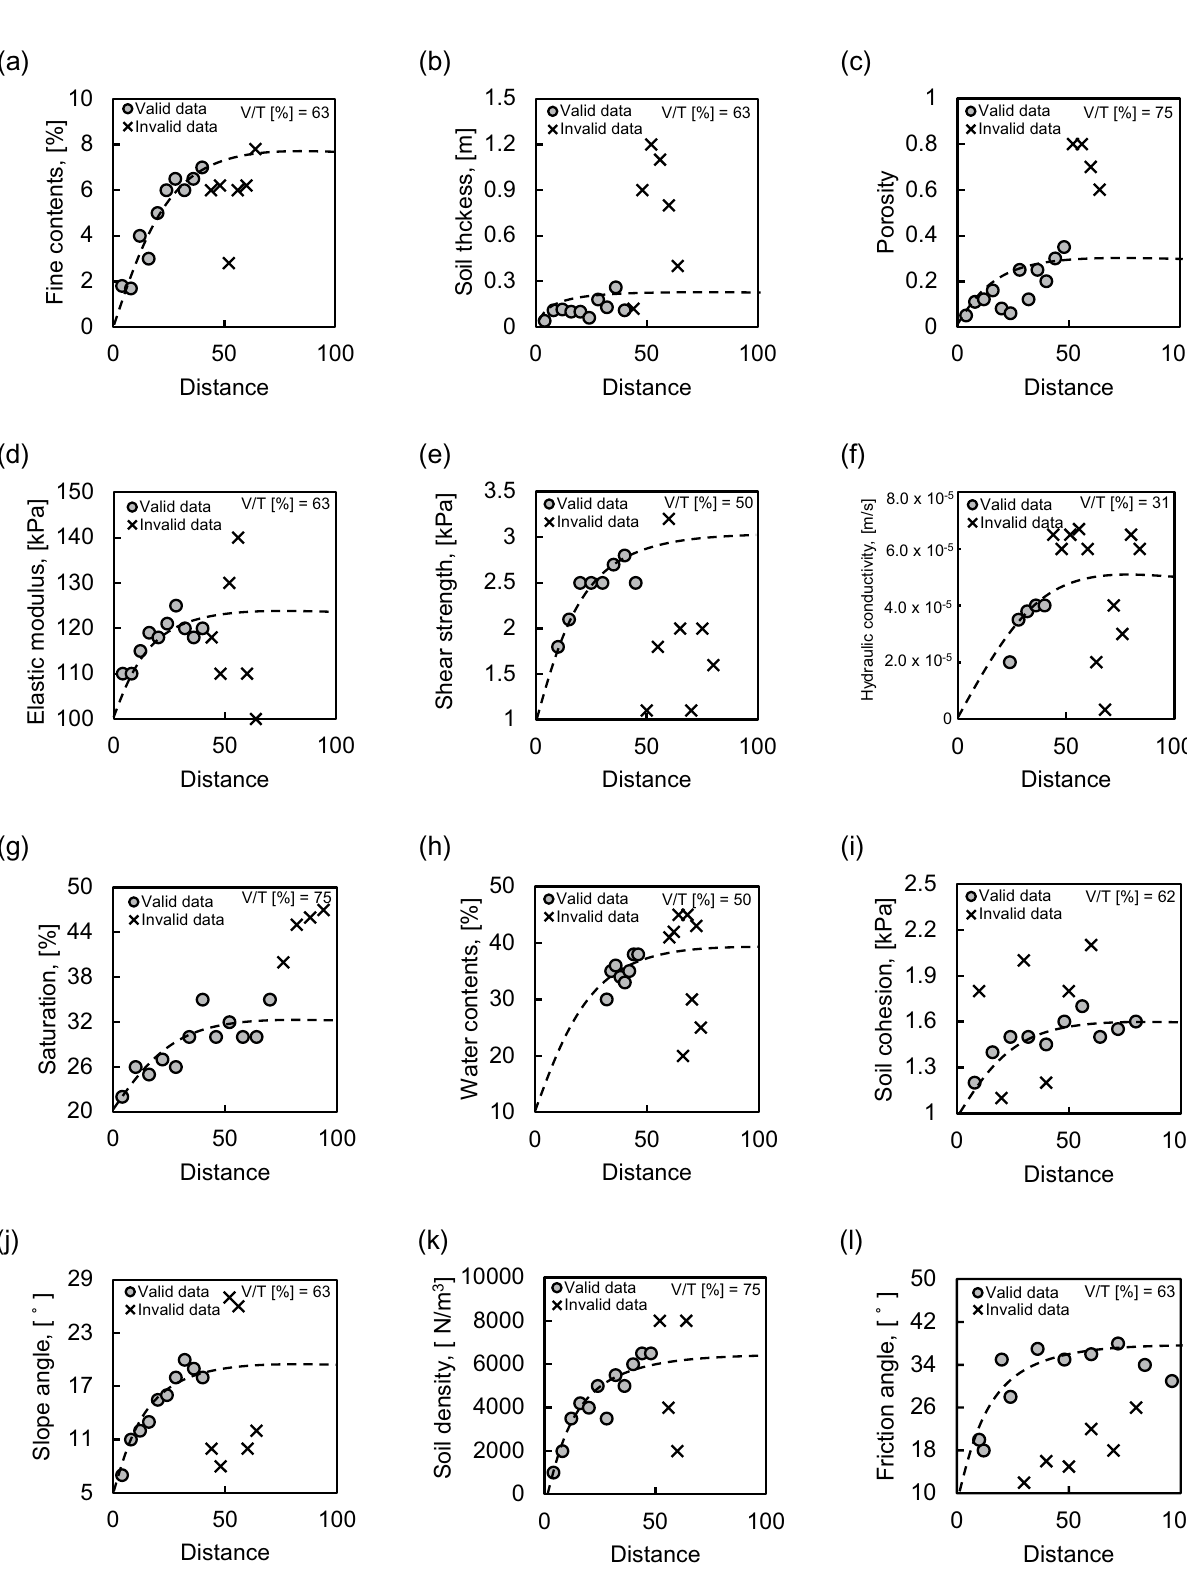
Figure 8. Variograms of input variables: ( a ) fine content; ( b ) soil thickness; ( c ) porosity; ( d ) elastic modulus; ( e ) shear strength; ( f ) hydraulic conductivity; ( g ) saturation; ( h ) water content; ( i ) soil cohesion; ( j ) slope angle; ( k ) soil density; ( l ) friction